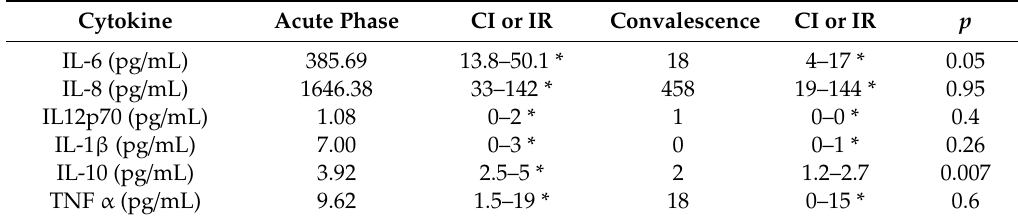
Table 5. Inflammatory cytokines during the febrile (acute phase) and afebrile (convalescence) phases.